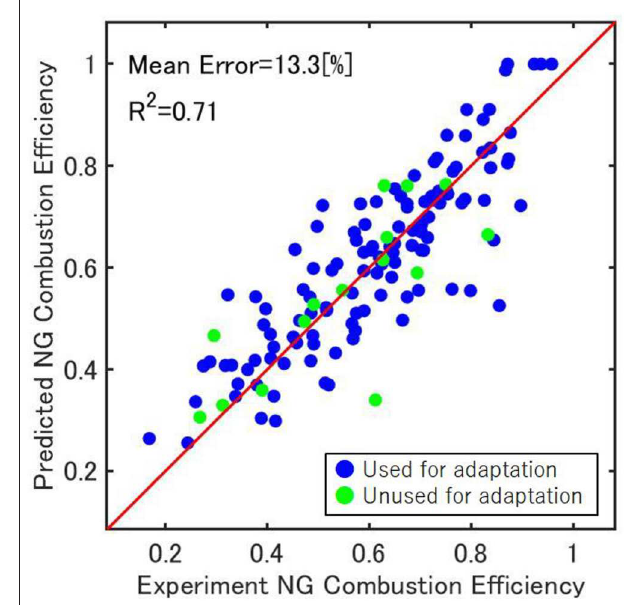
FIGURE 6 | Prediction accuracy of the combustion